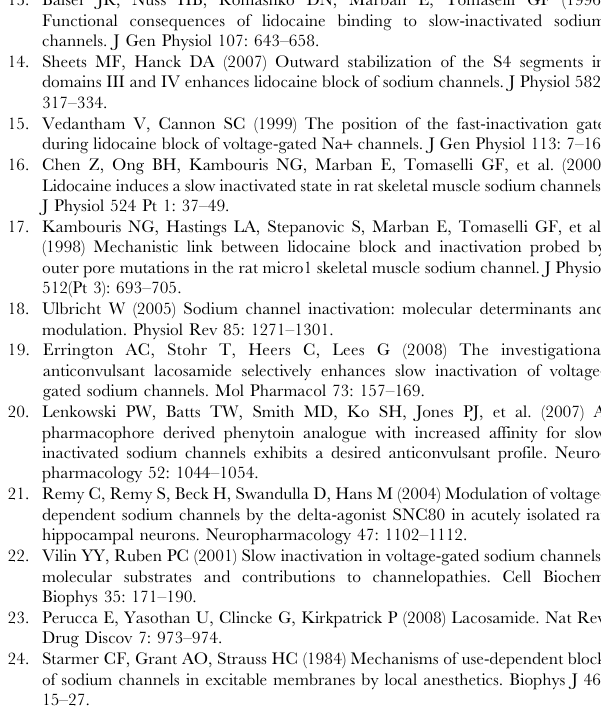
Table S4 Ion channel-specific parameters of the MSA model DOC) Table S5 IC50 values for simulated drugs with different CF